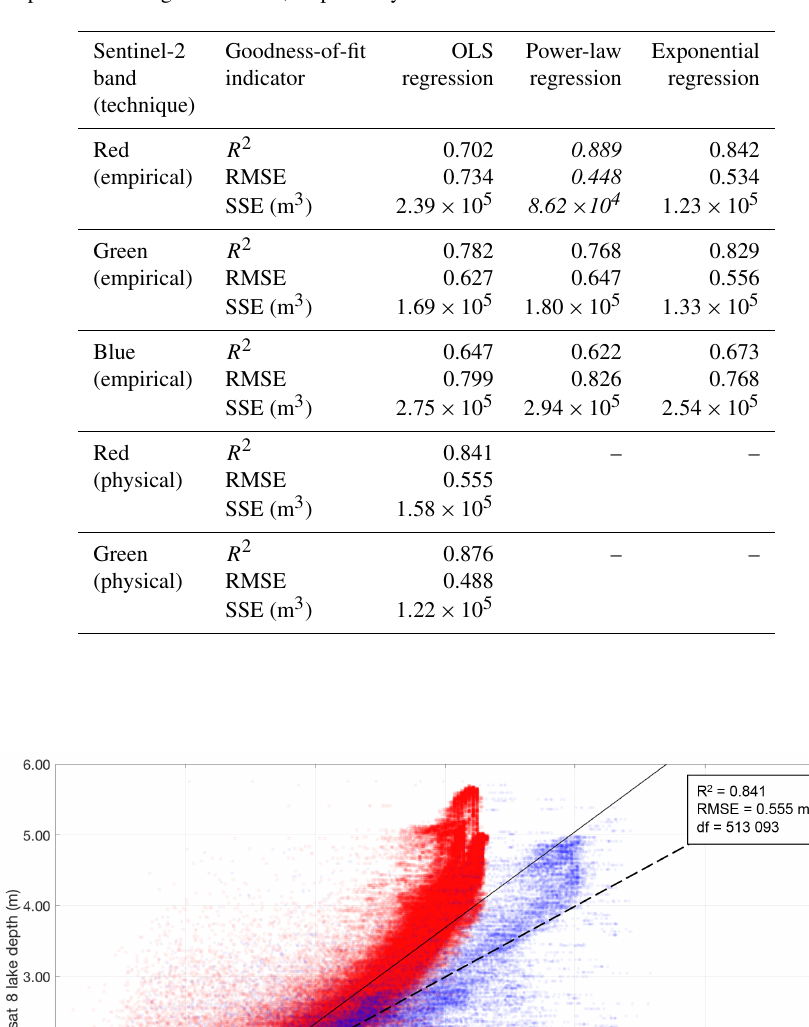
Table 1. Goodness-of-fit indicators for the empirical and physical techniques tested in this paper for deriving Sentinel-2 lake depths, with validation against the Landsat 8 lake depth measurements, on 1 and 31 July 2016. R 2 is the coefficient of determination, RMSE is the root-mean-square error, SSE is the sum of squares due to error, and OLS is ordinary least squares. The best performing (red band) regression relationship (i.e. the one with the highest R 2 and lowest RMSE and SSE) among the empirical techniques is shown in italicised text. Data for the physical relation applied to Sentinel-2’s green band are presented in Fig. S2, and data for the empirical relation applied to Sentinel-2’s green and blue bands are presented in Figs. S3 and S4, respectively.